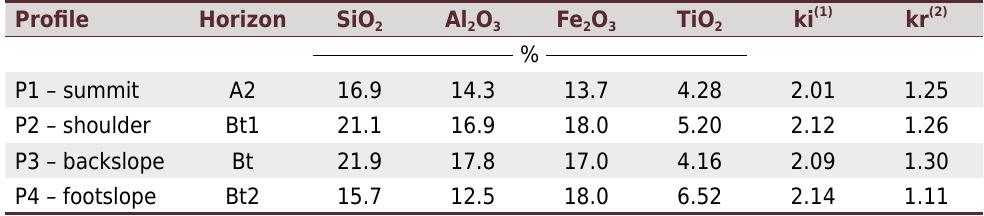
Table 5. Element levels, expressed as oxides extracted by sulfuric acid digestion (1:1) and molecular relationships ki and kr in soil horizons from a toposequence in Pinheiral, RJ